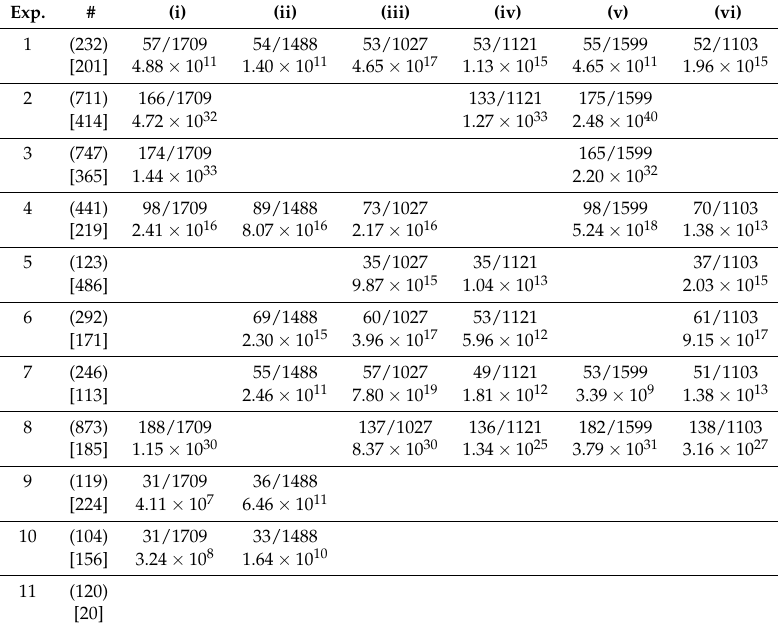
Table 8. In each of the 11 experiments, 20 top-ranked significant tissues whose set of downregulated genes significantly overlapped with the set of genes selected for each experiment were identified.